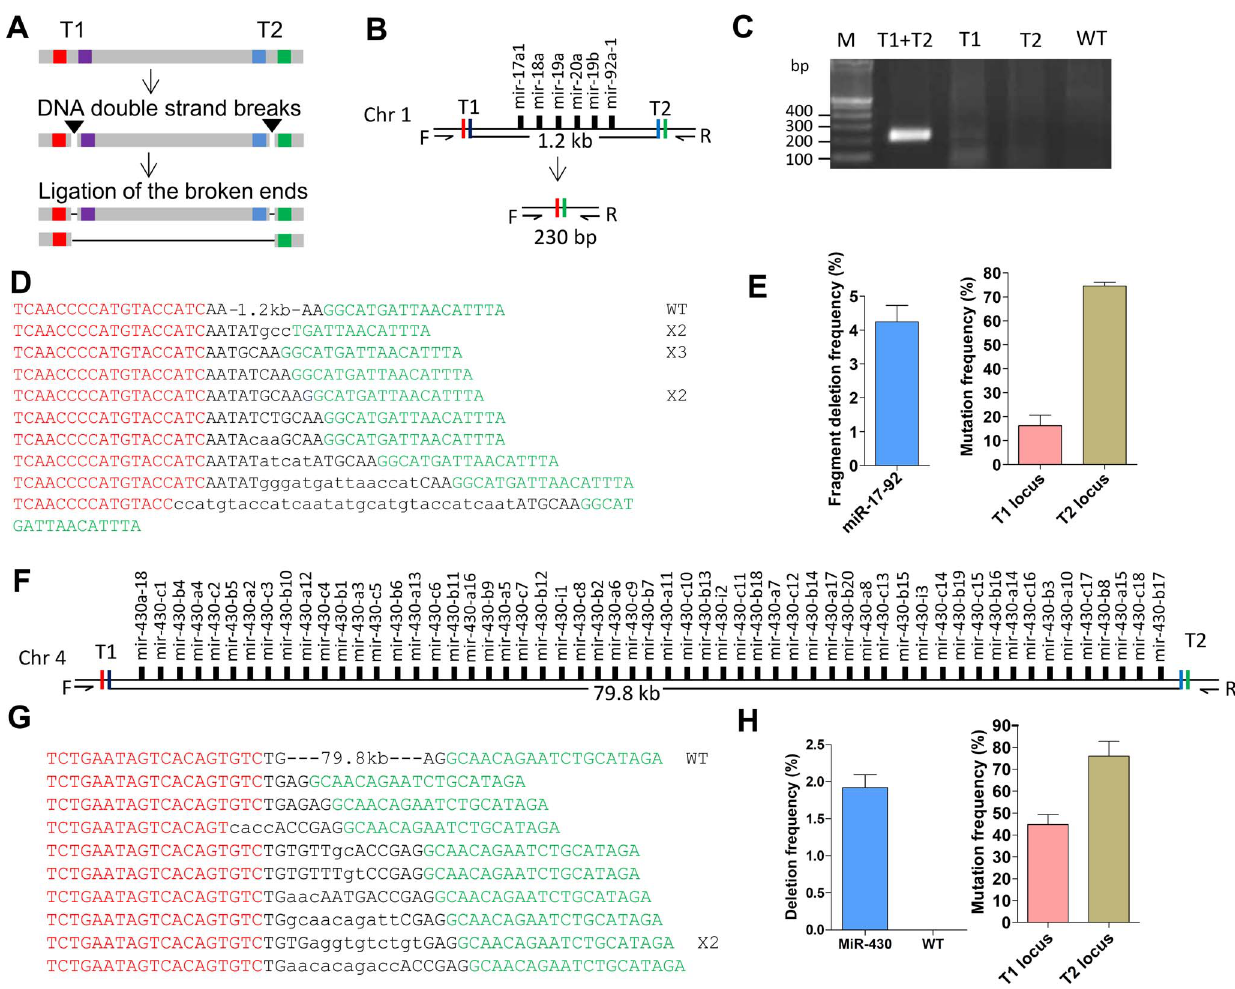
Figure 2. Precise large genomic deletions of miRNA gene clusters. ( A ) Schematic diagram of the large genomic deletion strategy using dual TALEN. The TALEN binding sites are shown in color. T1, TALEN pair 1; T2, TALEN pair 2. ( B ) Schematic representation of the zebrafish miR-17-92 cluster and the designed TALENs for its deletion. After genomic deletions, a band of about 230 bp is expected to be amplified by PCR using the designed primers. ( C ) Genomic PCR showing deletion of the miR-17-92 cluster. Gel picture showing PCR amplification of genomic DNA isolated from the pooled zebrafish embryos microinjected with two pairs of TALENs, one pair of TALENs or the wild-type control. ( D ) Sequencing results confirmed deletion of the miR-17-92 cluster. Alien nucleotides inserted are indicated by lowercase letters. The number of times each mutant allele appearing are shown on the right side of the mutant allele. ( E ) Deletion frequency of the miR-17-92 cluster and indel-mutation frequency of the T1 and T2 loci. Genomic DNA was isolated from pooled zebrafish embryos injected with the two pairs of TALENs. Data shown are mean values 6 S.E.M from three replicates. ( F ) Schematic representation of the zebrafish miR-430 cluster and the designed TALENs. ( G ) Sequencing results confirmed deletion of the miR-430 cluster. Alien nucleotides inserted are indicated by lowercase letters. ( H ) Deletion frequency of the miR-430 cluster and indel-mutation frequency of the T1 and T2 loci. Genomic DNA was isolated from pooled zebrafish embryos injected with the two pairs of TALENs. Data shown are mean values 6 S.E.M from three replicates. the 1.2 kb miR-17-92 deletions to 1/24, 3/24 and 6/24 F1 embryos respectively (Fig. 4B). For malat1 , 4 out of the 32 P0 fish transmitted the 9.0 kb malat1 deletions to 1/32, 2/32, 4/32 and 5/ 32 F1 embryos respectively (Fig. 4D).